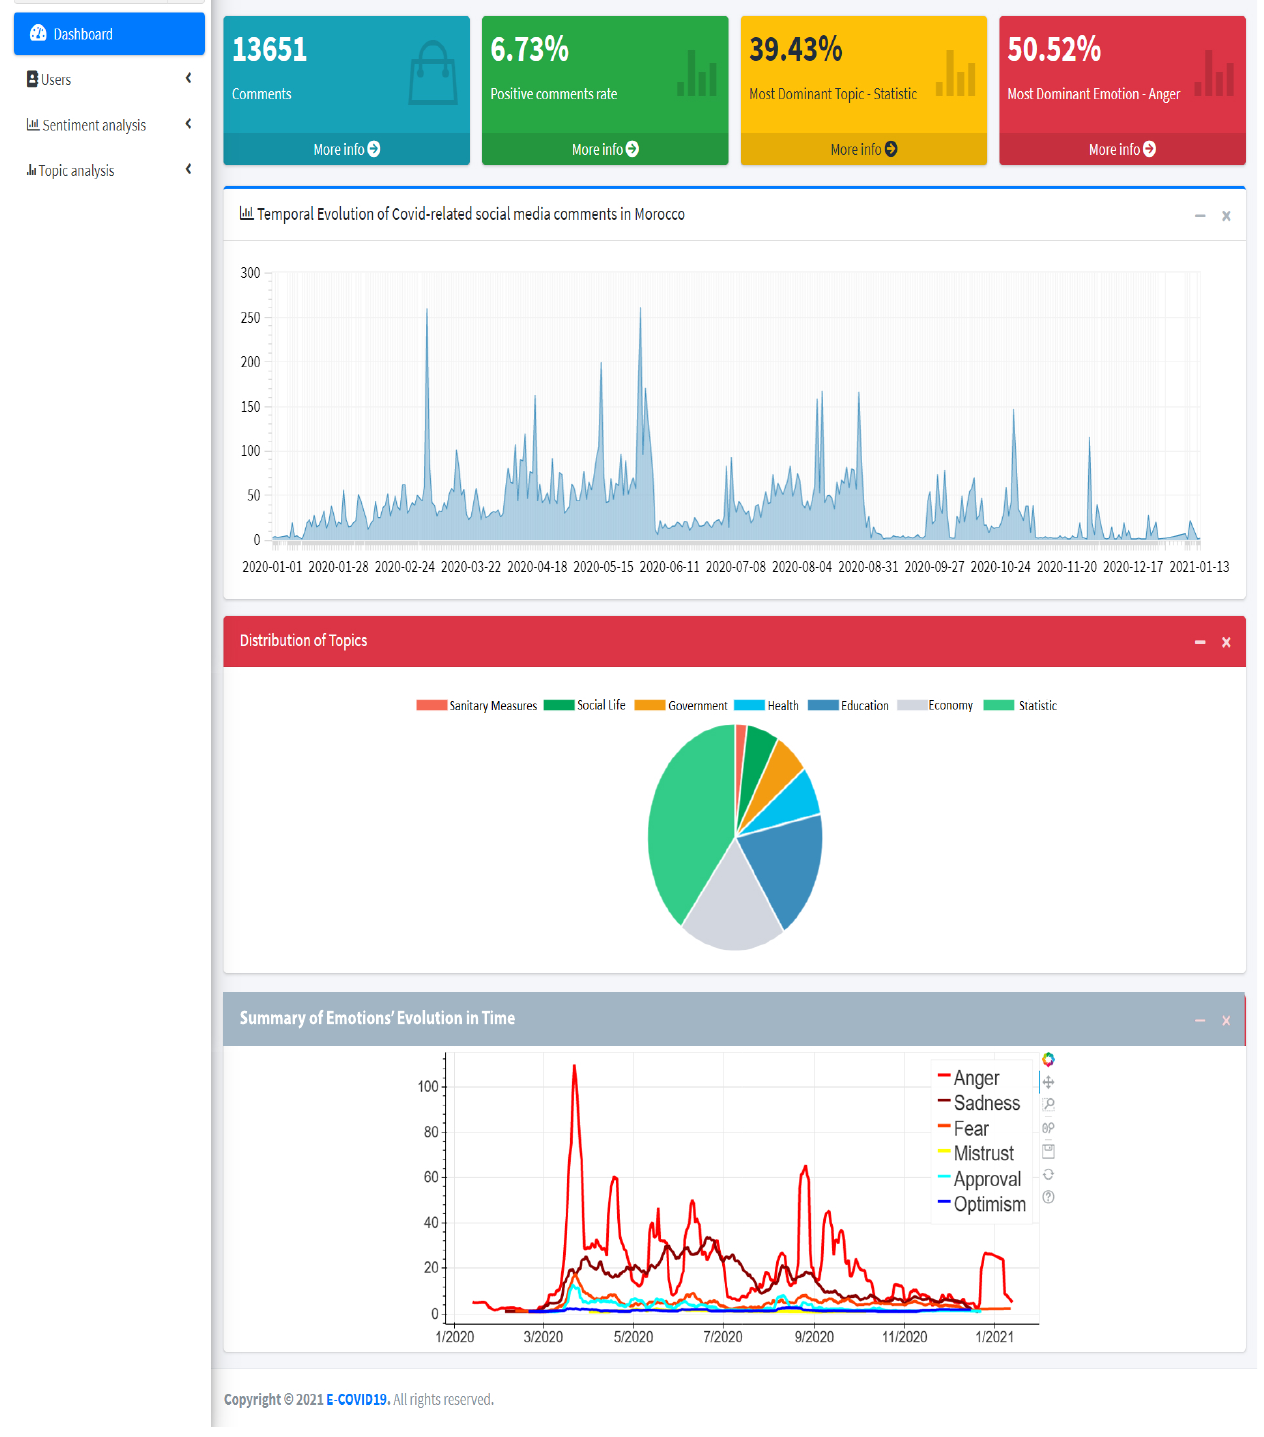
Figure 11. Moroccan platform for a better management of COVID-19